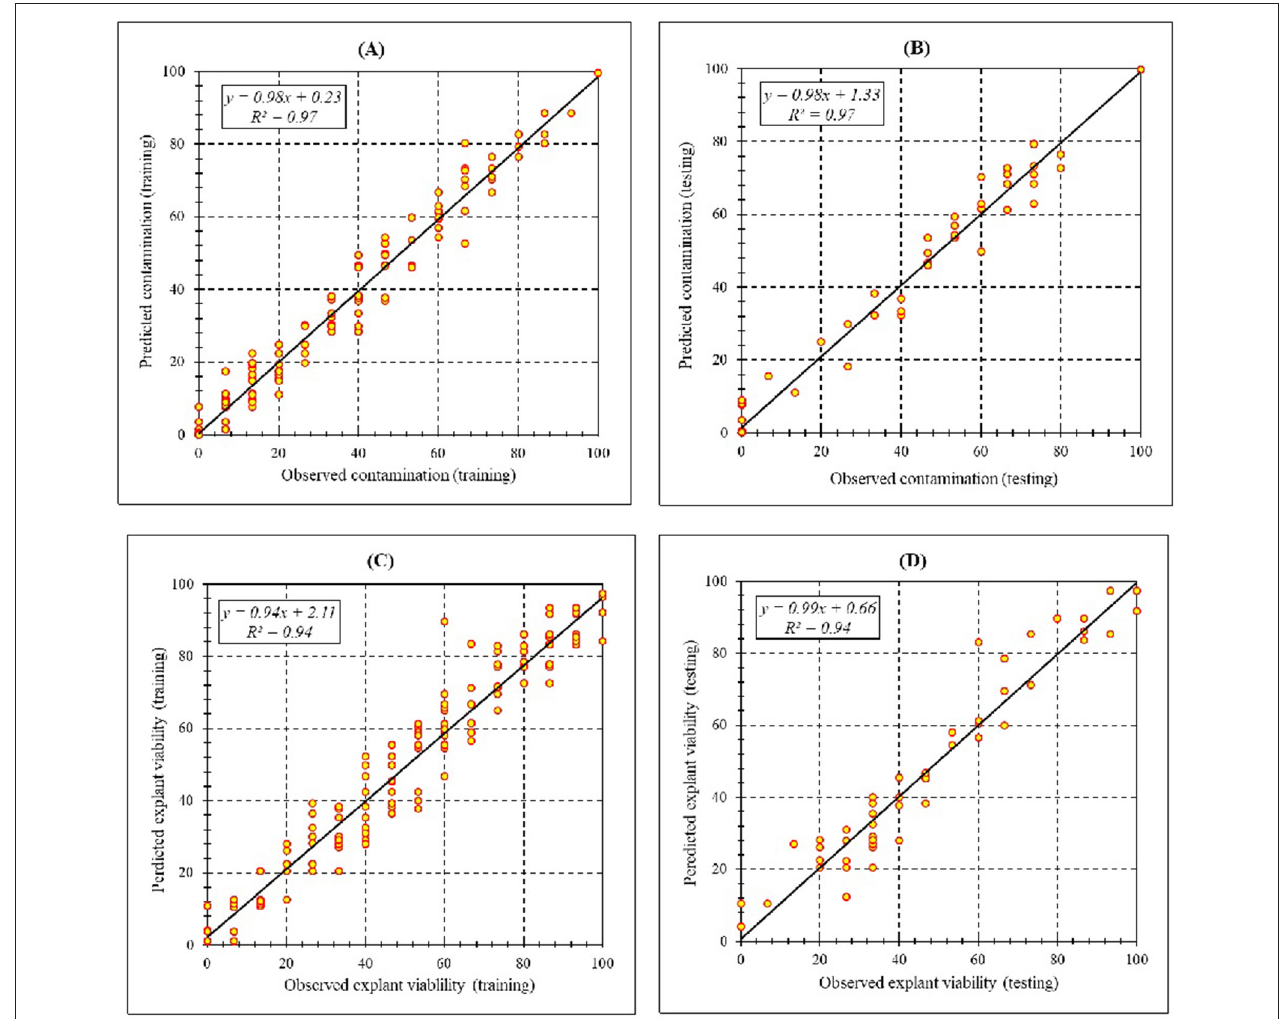
FIGURE 3 | Scatter plot of model predicted vs. observed values of (A) Training set ( n = 165); (B) testing set ( n = 54) of contamination frequency, (C) training set ( n = 165); (D) testing set ( n = 54) of explant viability during in vitro sterilization of chrysanthemum obtained by MLP model. Fitted simple regression line on scatter points was indicated by a solid